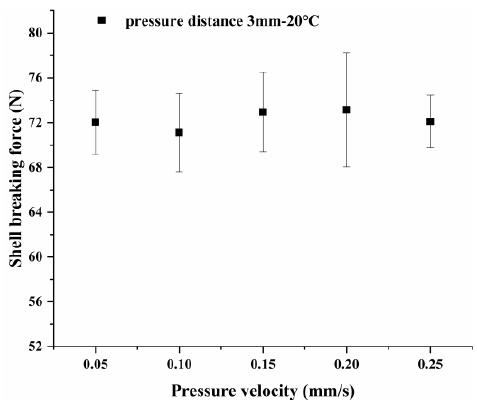
Figure 5. Pressing velocity – shell breaking force mechanical characteristics diagram.